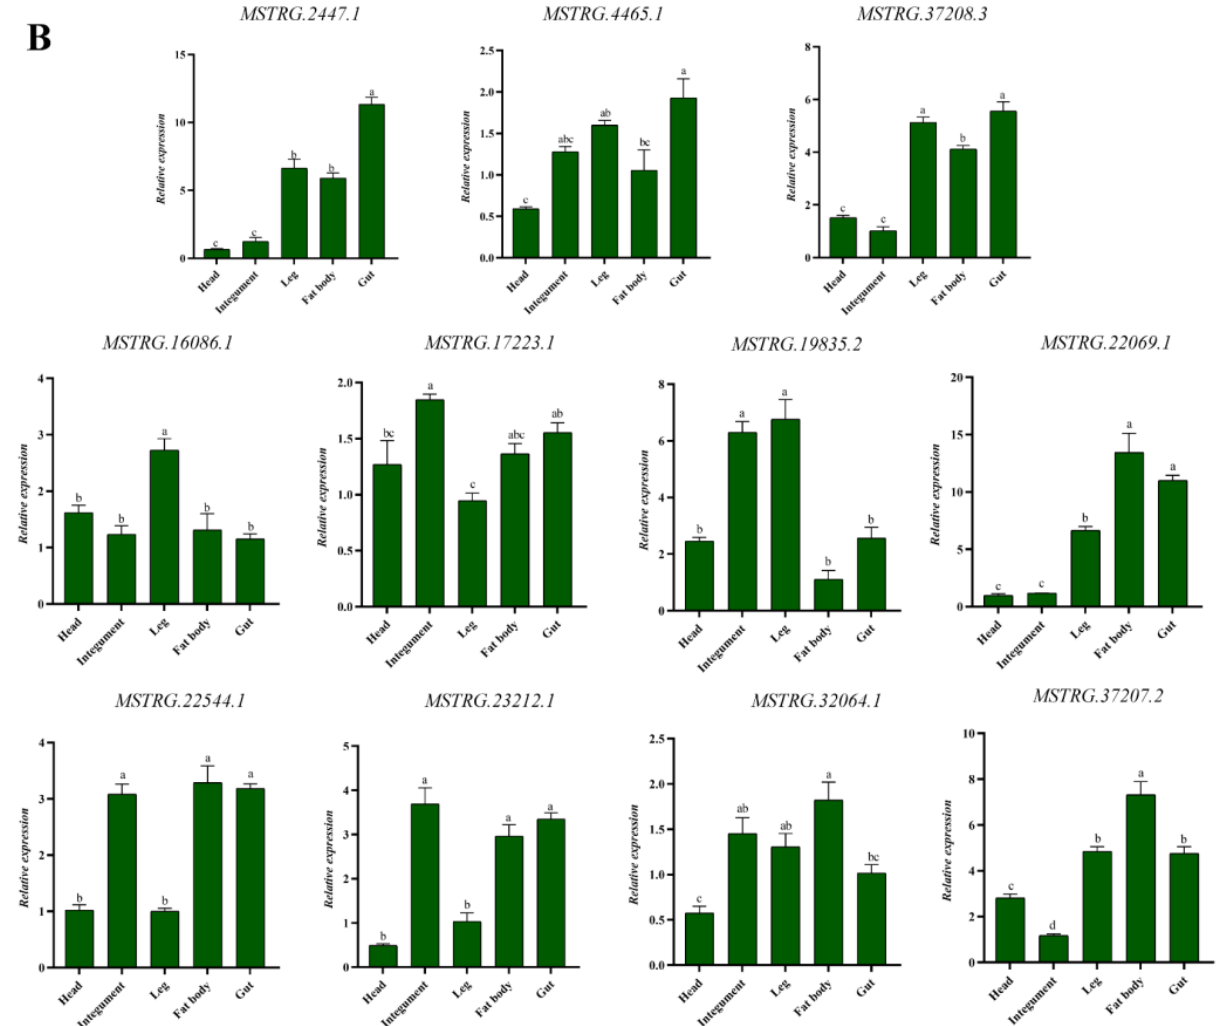
Figure 9. Developmental and tissue expression patterns of Profile 1 (MSTRG.37207.2, MSTRG.2447.1, MSTRG.17223.1, MSTRG.32064.1, MSTRG.37208.3, MSTRG.16086.1), Profile 6 (MSTRG.22069.1, MSTRG.4465.1, MSTRG.23212.1, MSTRG.19835.2), and MSTRG.22544.1 genes. ( A )